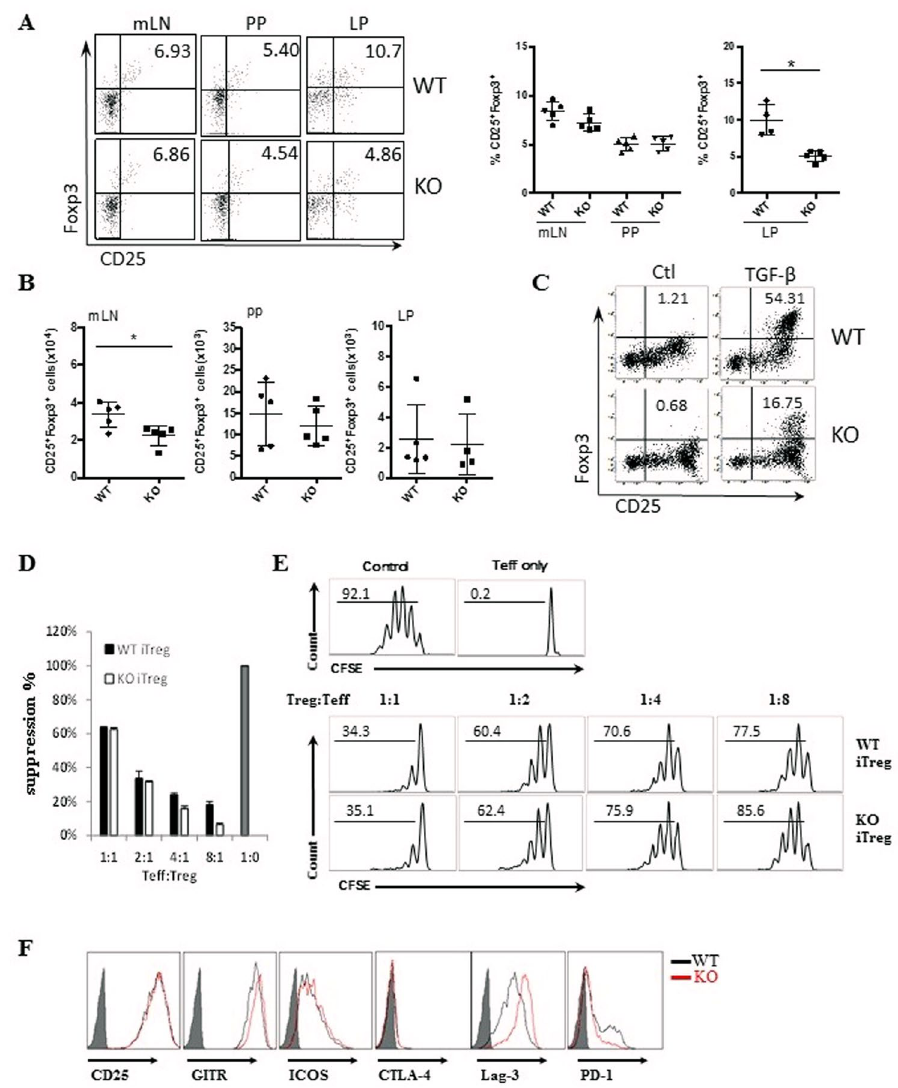
Figure 2. Effect of PD-1H on the conversion and function of iTreg. ( A ) PD-1H deficiency in the natural development of iTreg in gut-associated lymphoid organs. The percentages of CD25 + Foxp3 + Treg cells in the mesenteric lymph nodes (mLN), payer’s patch (PP) and lamina propria (LP) were determined by cell surface CD25 and intracellular Foxp3 expression with specific antibodies in flow cytometry. PD-1H KO mice and their WT littermates (n = 5 per group) were used for analysis. The left panel represents paired individual mice from each group and the right panel is a summary of one representative experiment (n = 5 in each group). ( B ) Absolute numbers of CD25 + Foxp3 + Treg in gut-associated lymphoid organs. ( C ) In vitro induction of iTreg. CD4 + CD25 − CD62L hi naïve T cells from WT and PD-1H KO mice were stimulated with anti-CD3/CD28 in the presence or absence of 5 ng/ml TGF- β for 3–5 days. The frequency of CD25 + Foxp3 + cells was determined by intracellular staining. ( D , E ) Assessing the suppressive function of iTreg in vitro . Naïve CD4 + T cells from WT or PD-1H KO Foxp3 (GFP) mice were induced to become Foxp3 (GFP + ) iTreg cells as described above. Naïve CD8 + T cells or CD4 + T cells were purified from B6 mice, labelled with CFSE, and co-cultured with sorted GFP + iTreg cells in the presence of anti-CD3 at the indicated Treg/Teff cells ratio. The decrease of CSFE upon inclusion of iTreg cells was determined by comparison with the wells without the addition of iTreg cells. Data shown are representative of at least 3 independent experiments. Teff only: T cells without anti-CD3 stimulation; Control: Teff cells with anti-CD3 without the inclusion of iTreg cells. ( F ) The expression of CD25, GITR, Lag- 3, CTLA-4, ICOS and PD-1 on the iTreg from WT or PD-1H KO Foxp3(GFP) mice were determined by flow cytometry gating on the CD4 + Foxp3(GFP + )